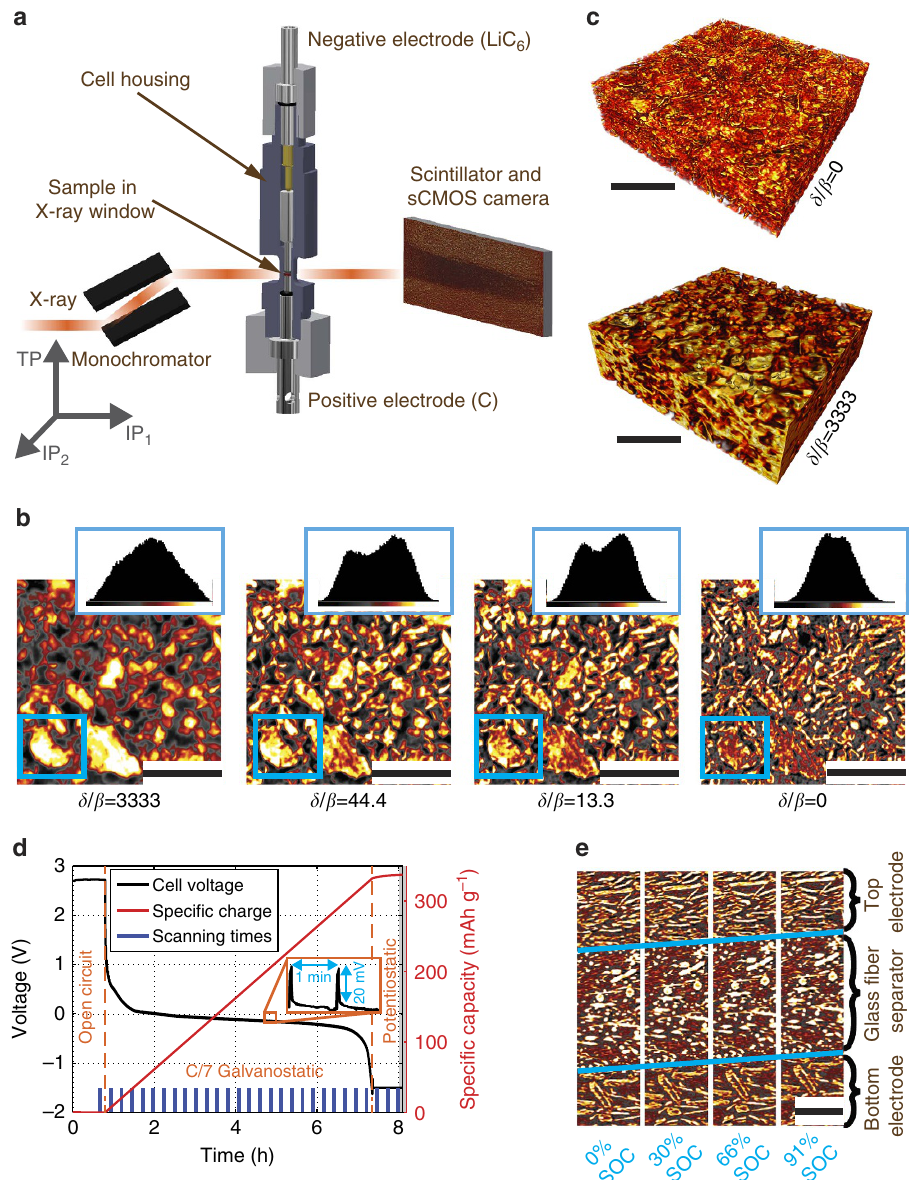
Figure 1 | Measurement setup and parameter selection. ( a ) Sketch of the electrochemical cell and the measurement setup, including a coordinate system indicating the two IP directions and the TP direction. ( b ) Comparison of a slice in the bottom electrode, where the phase has been retrieved with different d / b ratios. Insets show the respective colour-scale histograms. Scale bar length: 100 m m. ( c ) Microstructure rendering of a part of the bottom electrode using the retrieval parameters from the two extreme cases in ( b ). Scale bar length: 100 m m. ( d ) Specific charge, voltage and scanning times during operando electrochemical operation. The inset shows a zoom-in of the voltage profile arising from the applied galvanostatic intermittent titration technique protocol. ( e ) Vertical cuts through the sample at different states of charge. The blue lines mark the electrode–separator interfaces that shift on electrochemical operation. For better visibility, only a window around the separator is shown. Scale bar length: 50 m